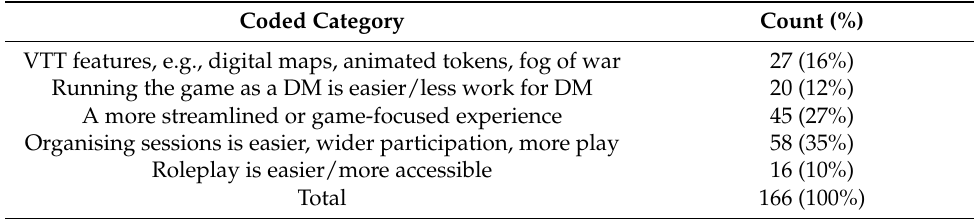
Table 1. Positive Experiences in Transitioning to Remote D&D. Coded